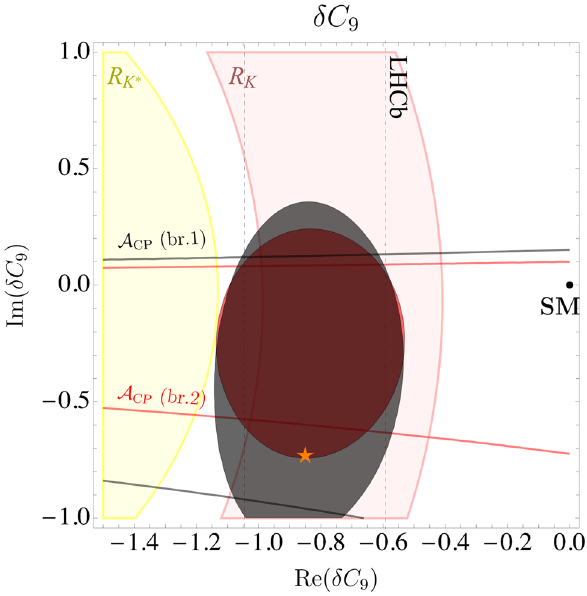
(cid:8) (cid:9) Fig. 1 Constraints on Re (δ C 9 ), Im (δ C 9 ) compatible with R exp and K R exp ,aswellaswiththeerrorbarson A CP measuredinthebinsbetween K ∗ 2GeV 2 < q 2 < 8GeV 2 , as reported in Ref. [15]. The horizontal lines correspond to the A CP constraint for branches 1 and 2, see text for details. Vertical dashed lines enclose the 2 σ region of Re (δ C 9 ) obtained from CP-averaged spectra in Ref. [16]. The scenario considered in this case is the one in which all of the BSM effects are described by δ C 9 only. The fitted 1 σ values of δ C 9 are ellipses in gray (red) for strong phases in branch 1 (2). By a star we denote our benchmark point which we chose to be δ C 9 = − 0 . 85 − 0 . 73